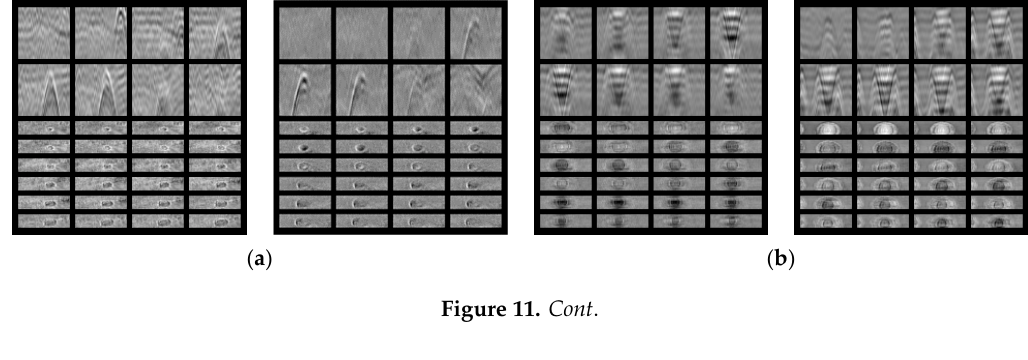
Figure 10. Representative core drilling results of ( a , b ) cavities and ( c , d ) gravels. A total of 1,056 GPR grid images of 256 cavities, 256 manholes, 256 subsoil backgrounds, and